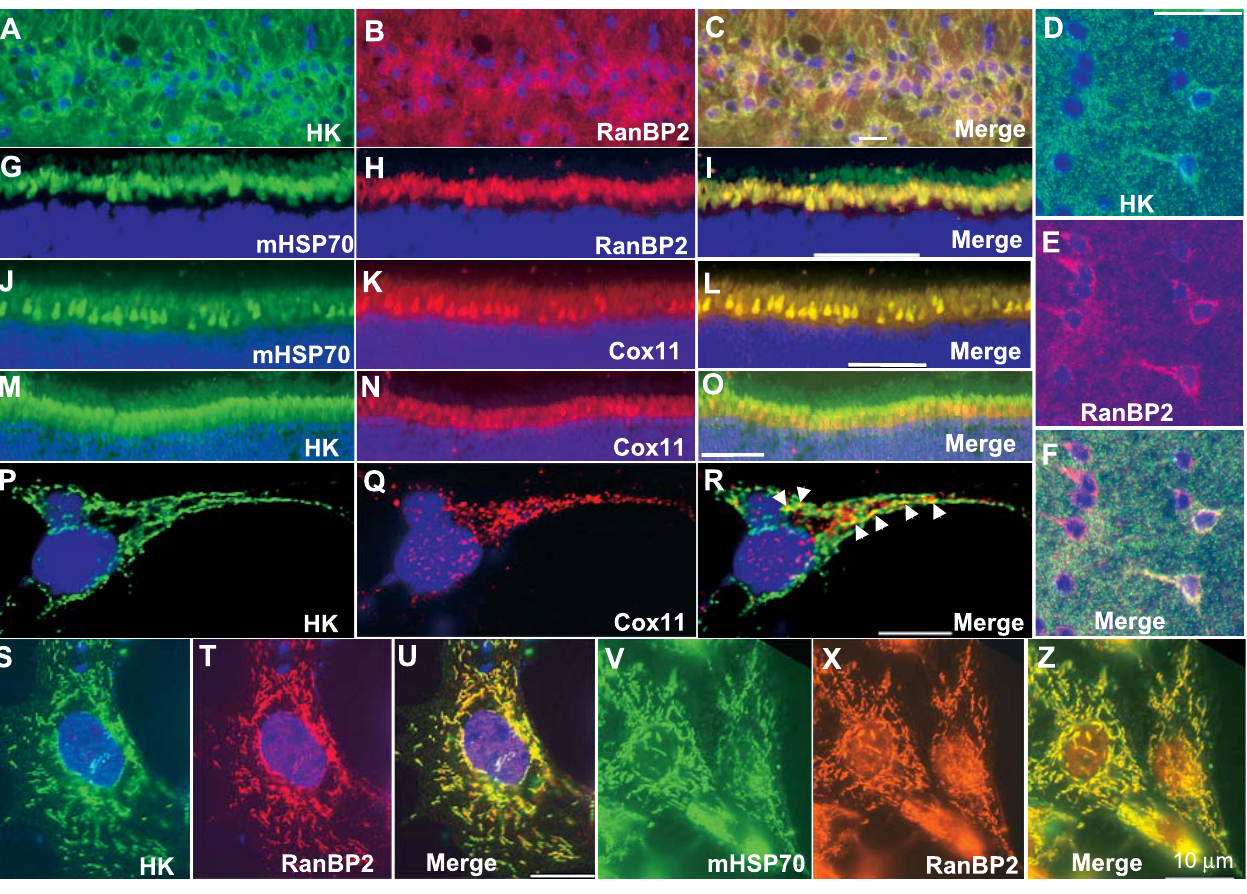
Figure 3. Localization of RanBP2 and Its LD Molecular Partners (A–F) are thin cryosections of an area of the hipocampus (CA1 neurons) and cerebral cortex, respectively, immunostained against HKI (A and D), RanBP2 (B and E), and merged images thereof (C and F). Note that while RanBP2 and HKI are widely expressed among and colocalize to hippocampal neurons (C), HKI expression and localization with RanBP2 is restricted to a subset of cortical neurons (likely interneurons) (F). Images of the distal region of bovine retinal cryosections comprising part of the nuclear layer of photoreceptor neurons and their inner (myoid and ellipsoid) segment compartment (G–O) are immunostained against mHsp70 (G) and RanBP2 (H), mHsp70 (J) and Cox11 (K), HKI (M) and Cox11 (N), and merged images thereof (I–O). Note the prominent localization of RanBP2, mHsp70, and Cox11 at the mitochondria-rich ellipsoid compartment of photoreceptors and the colocalization of RanBP2 and Cox11 with mHsp70 (I and L), while HKI colocalization with Cox11 was limited to restricted foci (R, arrowheads). High-resolution images of dissociated primary cerebral neurons and glial cells confirmed that the colocalization of HKI and Cox11 was highly restricted (P–R), while RanBP2 extensively colocalized with HKI (S–U) and mHsp70 (V–Z). Scale bars in A–O and P–Z are 40 and 10 l m, respectively. ONL, outer nuclear layer. DOI: